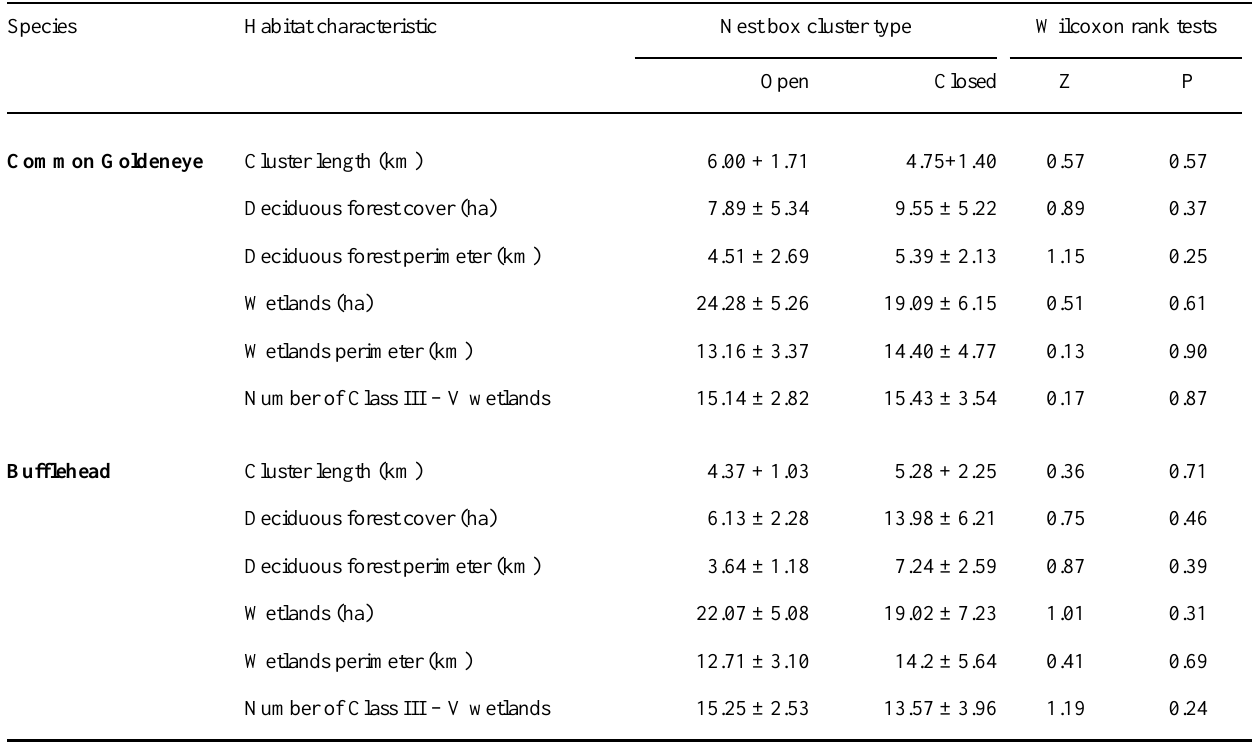
Table 1. Mean (± SE) cluster length and habitat characteristics of wetlands where nest boxes were open or closed to occupancy by Common Goldeneye ( Bucephala clangula ) and Bufflehead ( Bucephala albeola ) in the Buffalo Lake Moraine, Alberta in 2004. Analyses were completed using Wilcoxon Rank Sum test (z scores) using seven open and seven closed clusters for Common Goldeneye, and eight (open) and seven (closed) clusters for